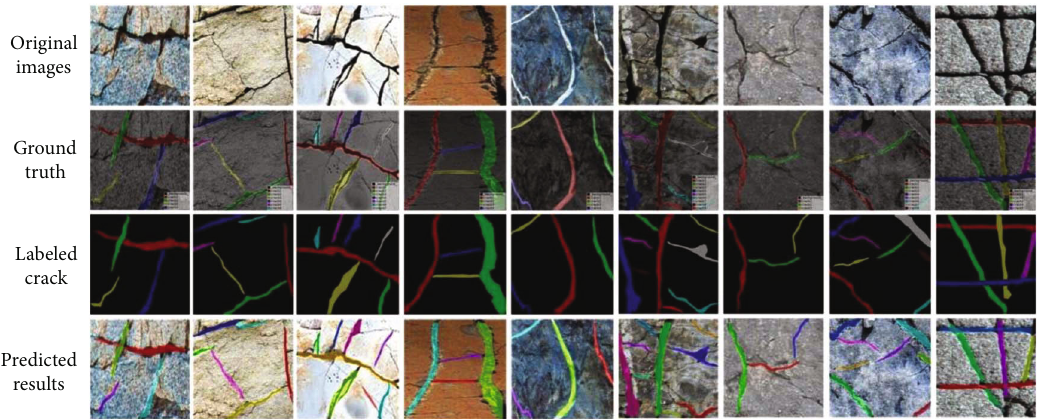
Figure 17: Examples of predicted results of the multi-CrackNet on 3 more sets of crack detections.